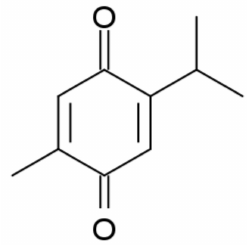
Figure 1. Structure of